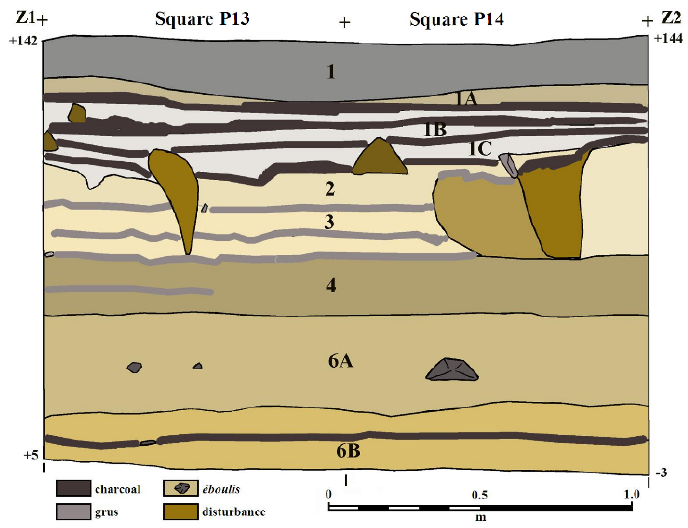
Figure 4. Profile Z1–Z2, Saradj-Chuko Grotto, Russia . In Squares Q13–Q14, nine geoarchaeological layers were identified. Cutting through Layers 2–3 in Square P17, the large disruption that begins just beneath the label for Layer 1C is likely a Medieval smelting pit or a slag discard